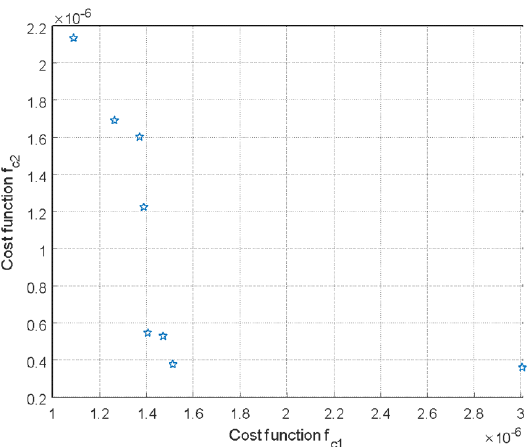
Figure 6. The MOGA ’s optimal solutions, forming the optimal Pareto front for the same problem Figure 6. The MOGA’s optimal solutions, forming the optimal Pareto front for the same problem solved by the SOGA. solved by the